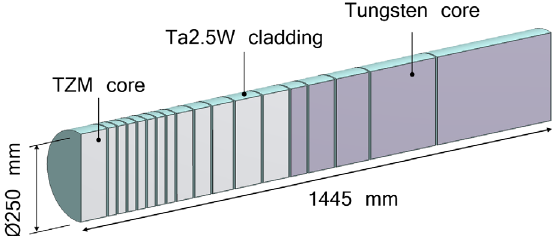
FIG. 1. Layout of the beam dump facility target core. The target blocks are made of TZM or pure tungsten cylinders clad with a tantalum alloy,